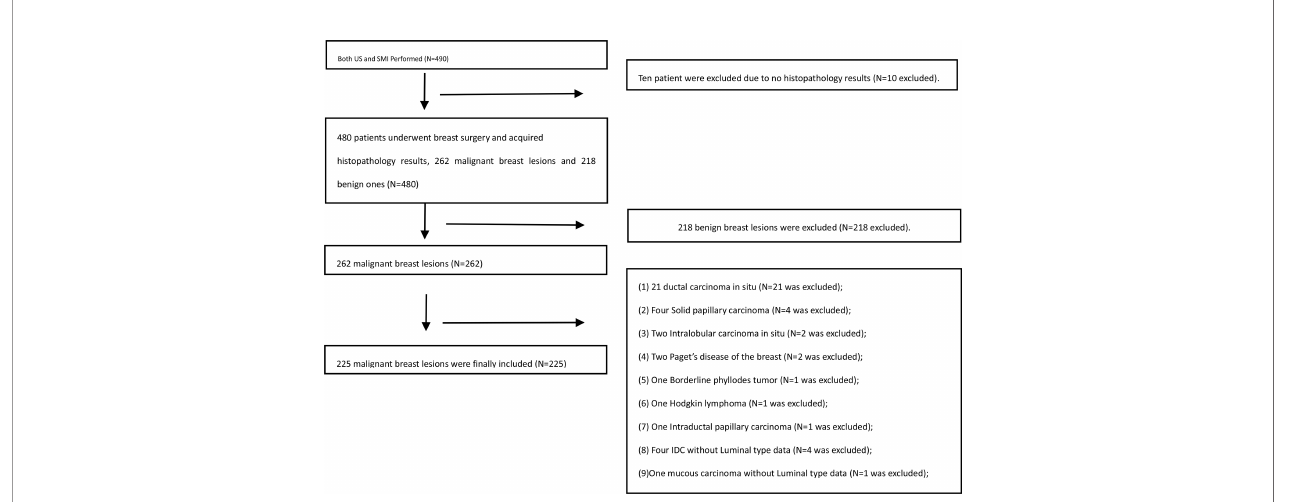
FIGURE 1 | Flowchart of patient selection and inclusion in the